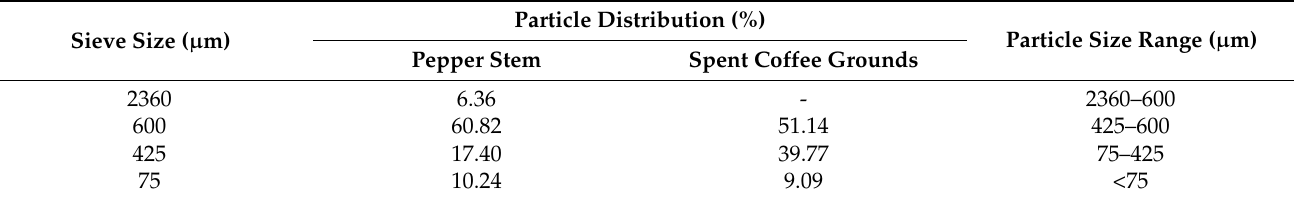
Table 3. Particle size analysis of the samples.